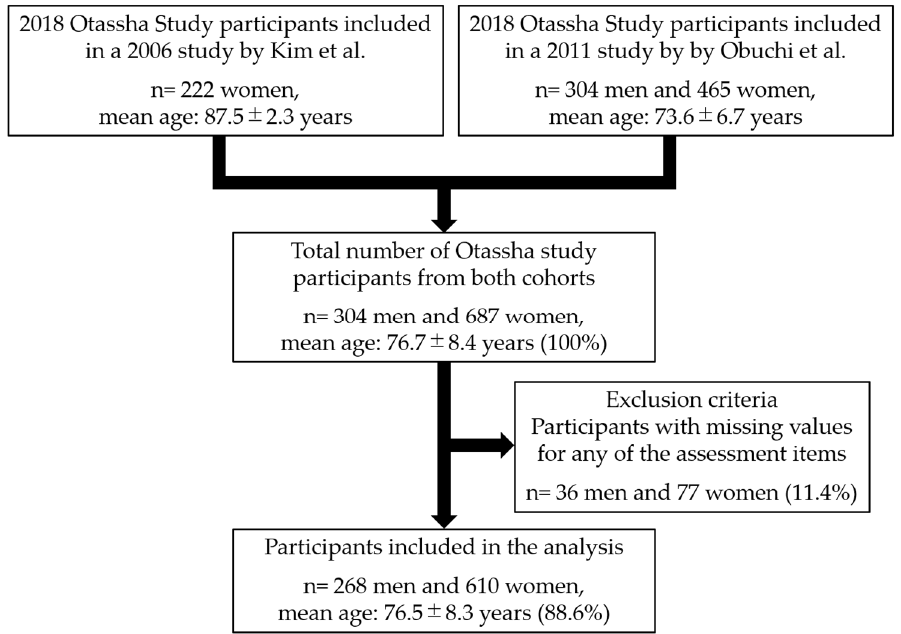
Figure 1. Flowchart of the study design.